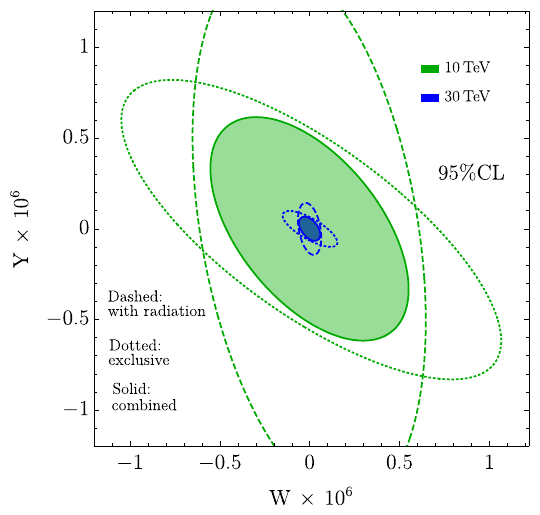
Figure 6. 95% CL sensitivities to the W and Y at the 10 and 30 TeV muon collider.